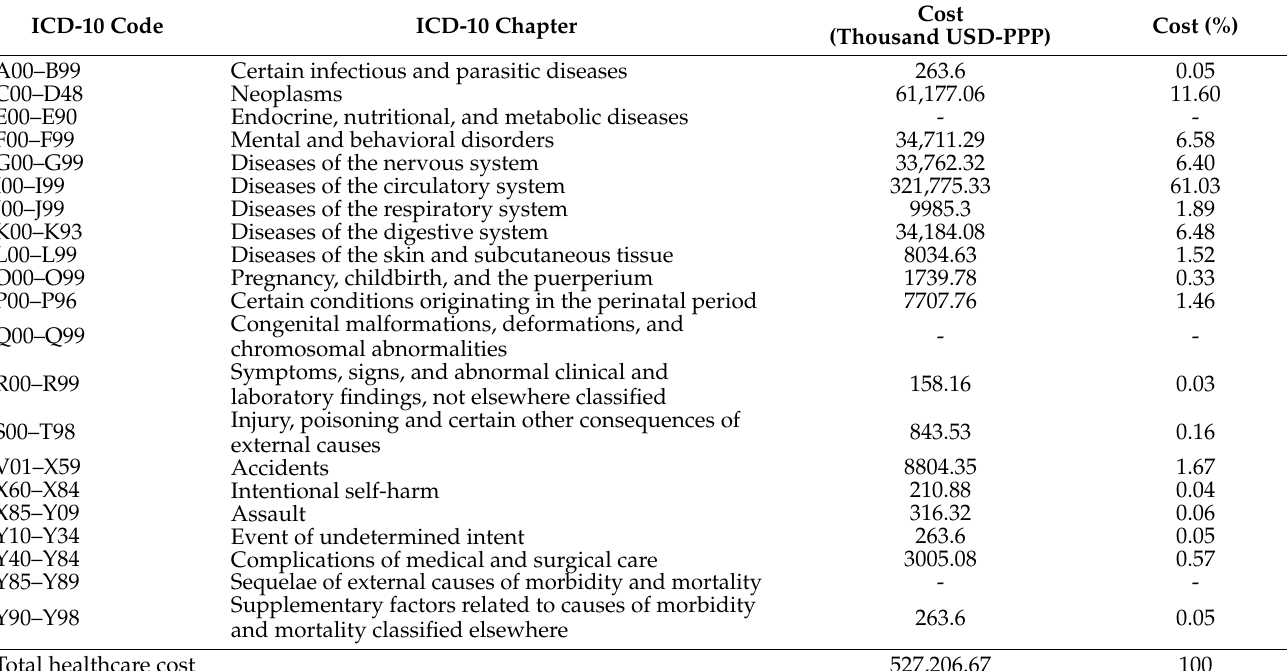
Table 5. Healthcare cost stratified by type of disease, attributable to alcohol in percentage, 2017.